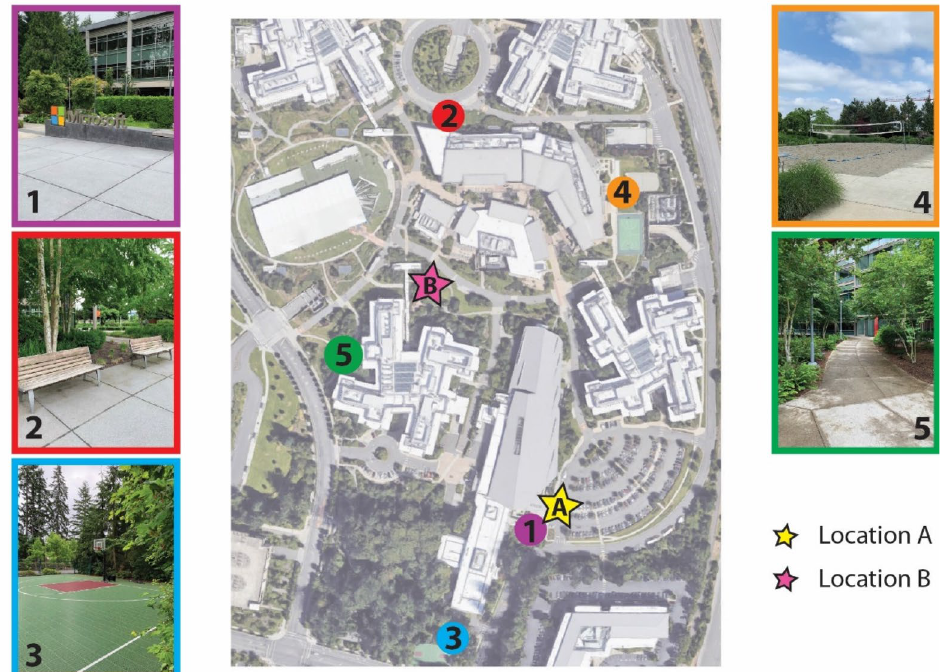
Figure 2. Overhead view of the scavenger hunt on the Microsoft campus. POI locations are denoted by the numbers and colored circles: Microsoft Sign (1; purple), Two Benches (2; red), Basketball Court (3; blue), Volleyball Court (4; orange), and Hidden Door (5; green). The locations of the pointing tasks are denoted with stars: Location A ( A ; yellow) and Location B ( B ;